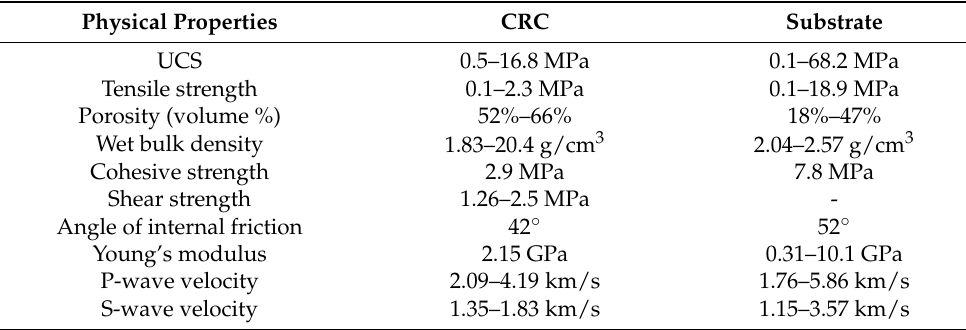
Table 1. Physical Properties of CRC and